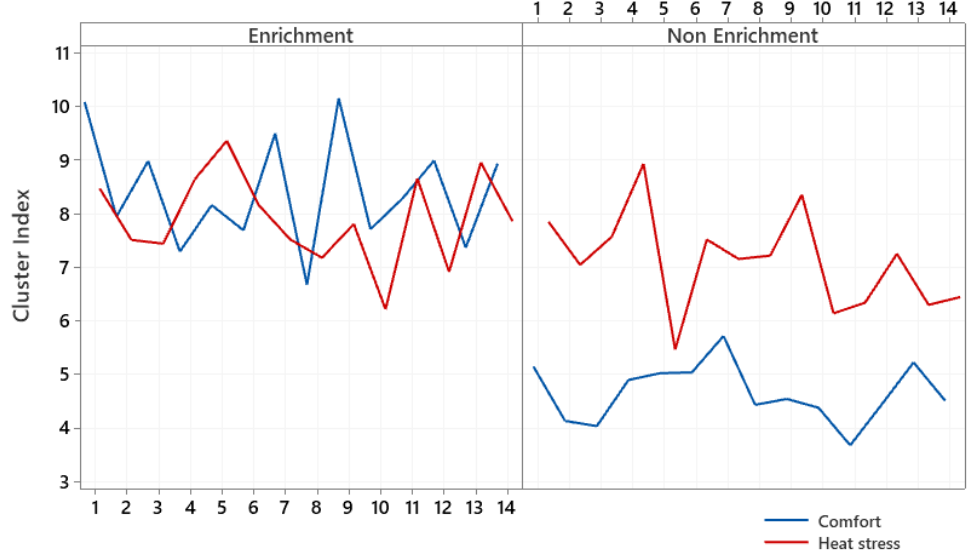
Figure 5. Cluster index of the group of broilers housed in enriched and nonenriched environments under the effect of comfort and heat stress.